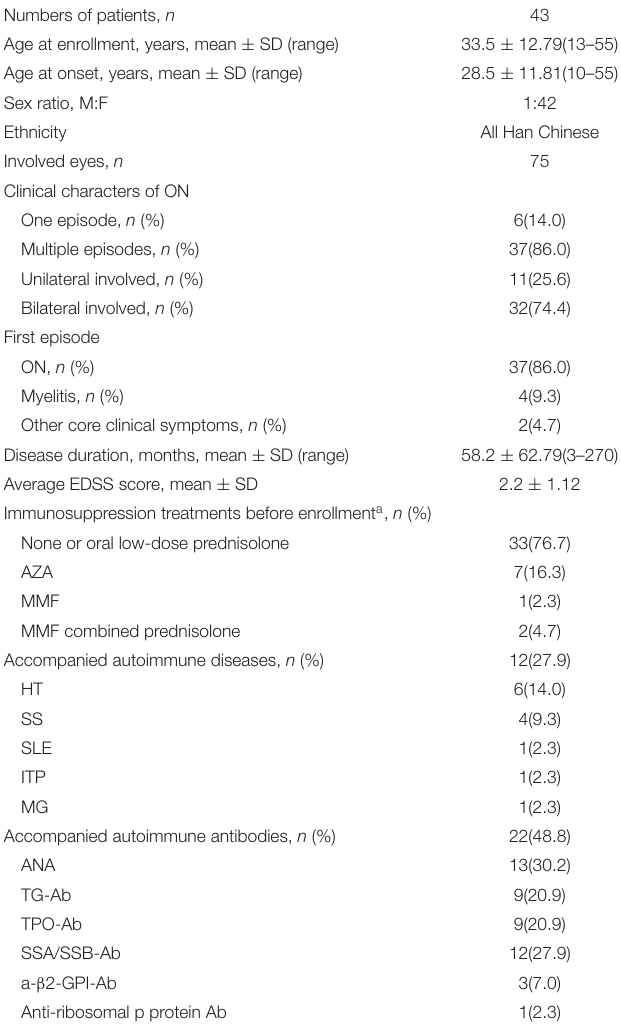
TABLE 1 | Demographic and clinical manifestations of NMO-ON